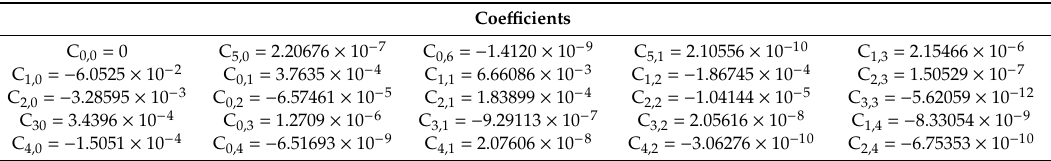
Table 2. Coe ffi cients for the proposed